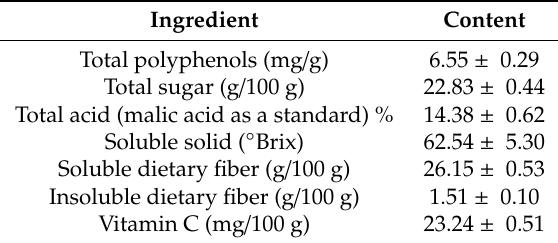
Table 1. The primary ingredients in seabuckthorn freeze-dried